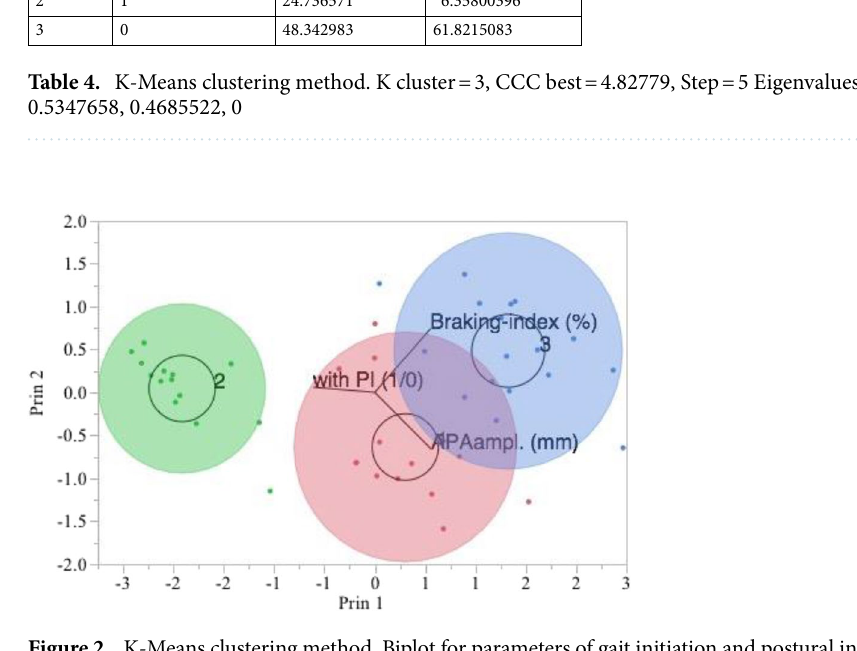
Figure 2. K-Means clustering method. Biplot for parameters of gait initiation and postural instability. Clusters 2, based on the parameters of gait initiation (APA amplitue and Braking-index) and postural instability, stands out from the others. This is supported by its parallel coordinate plot in Fig. 3(2), which differs from the plots for the other